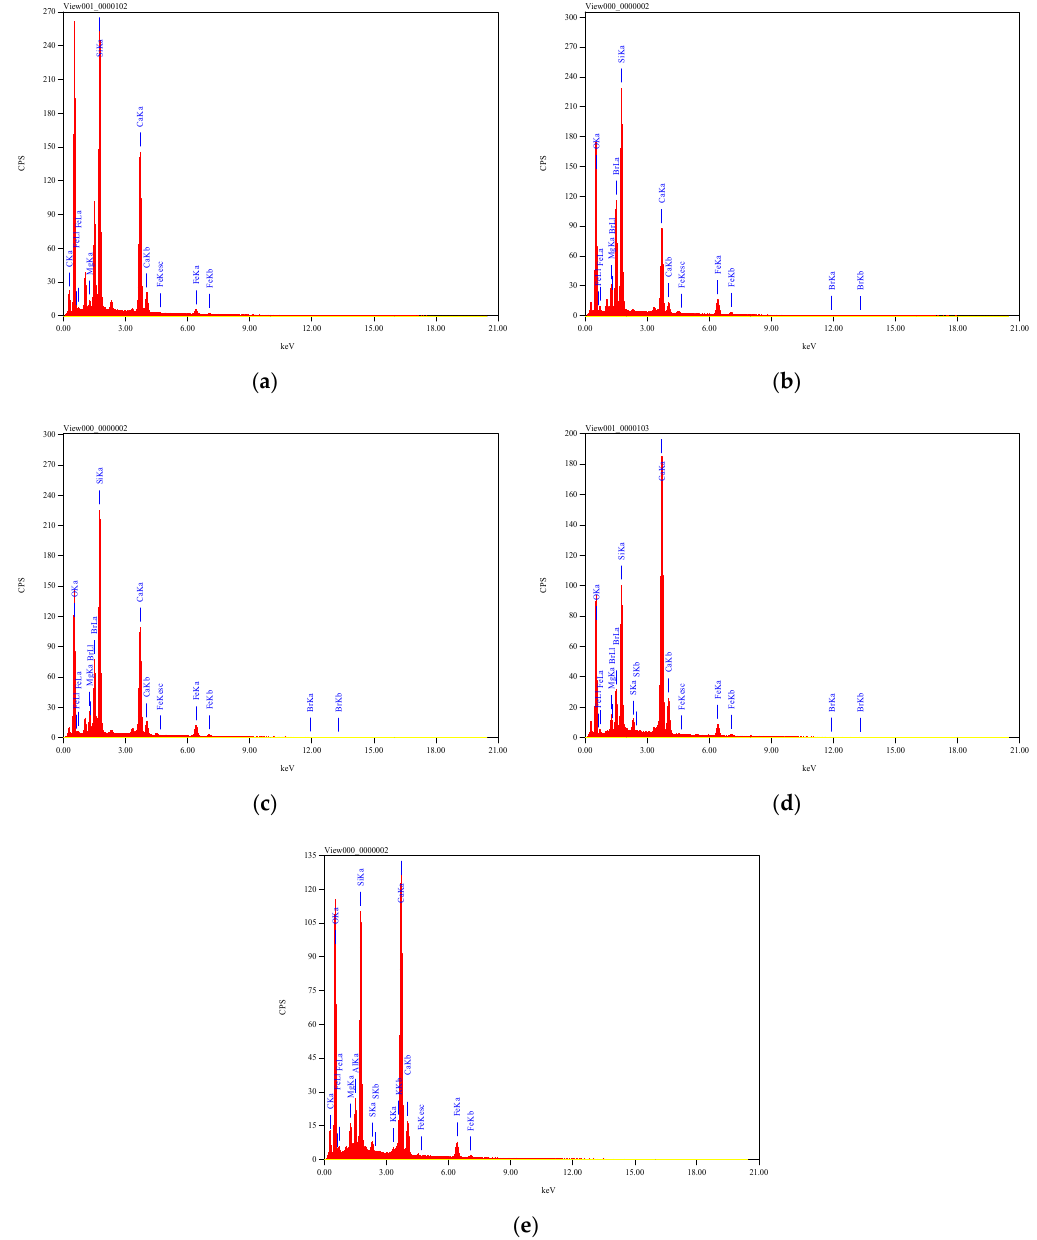
Figure 17. EDS results of the tested mixes: ( a ) M2 (40% RFCA); ( b ) M9 (40% RFNA); ( c ) M6 (10% RCP); ( d ) M13 (10% AMF); ( e ) M16 (10% SF).